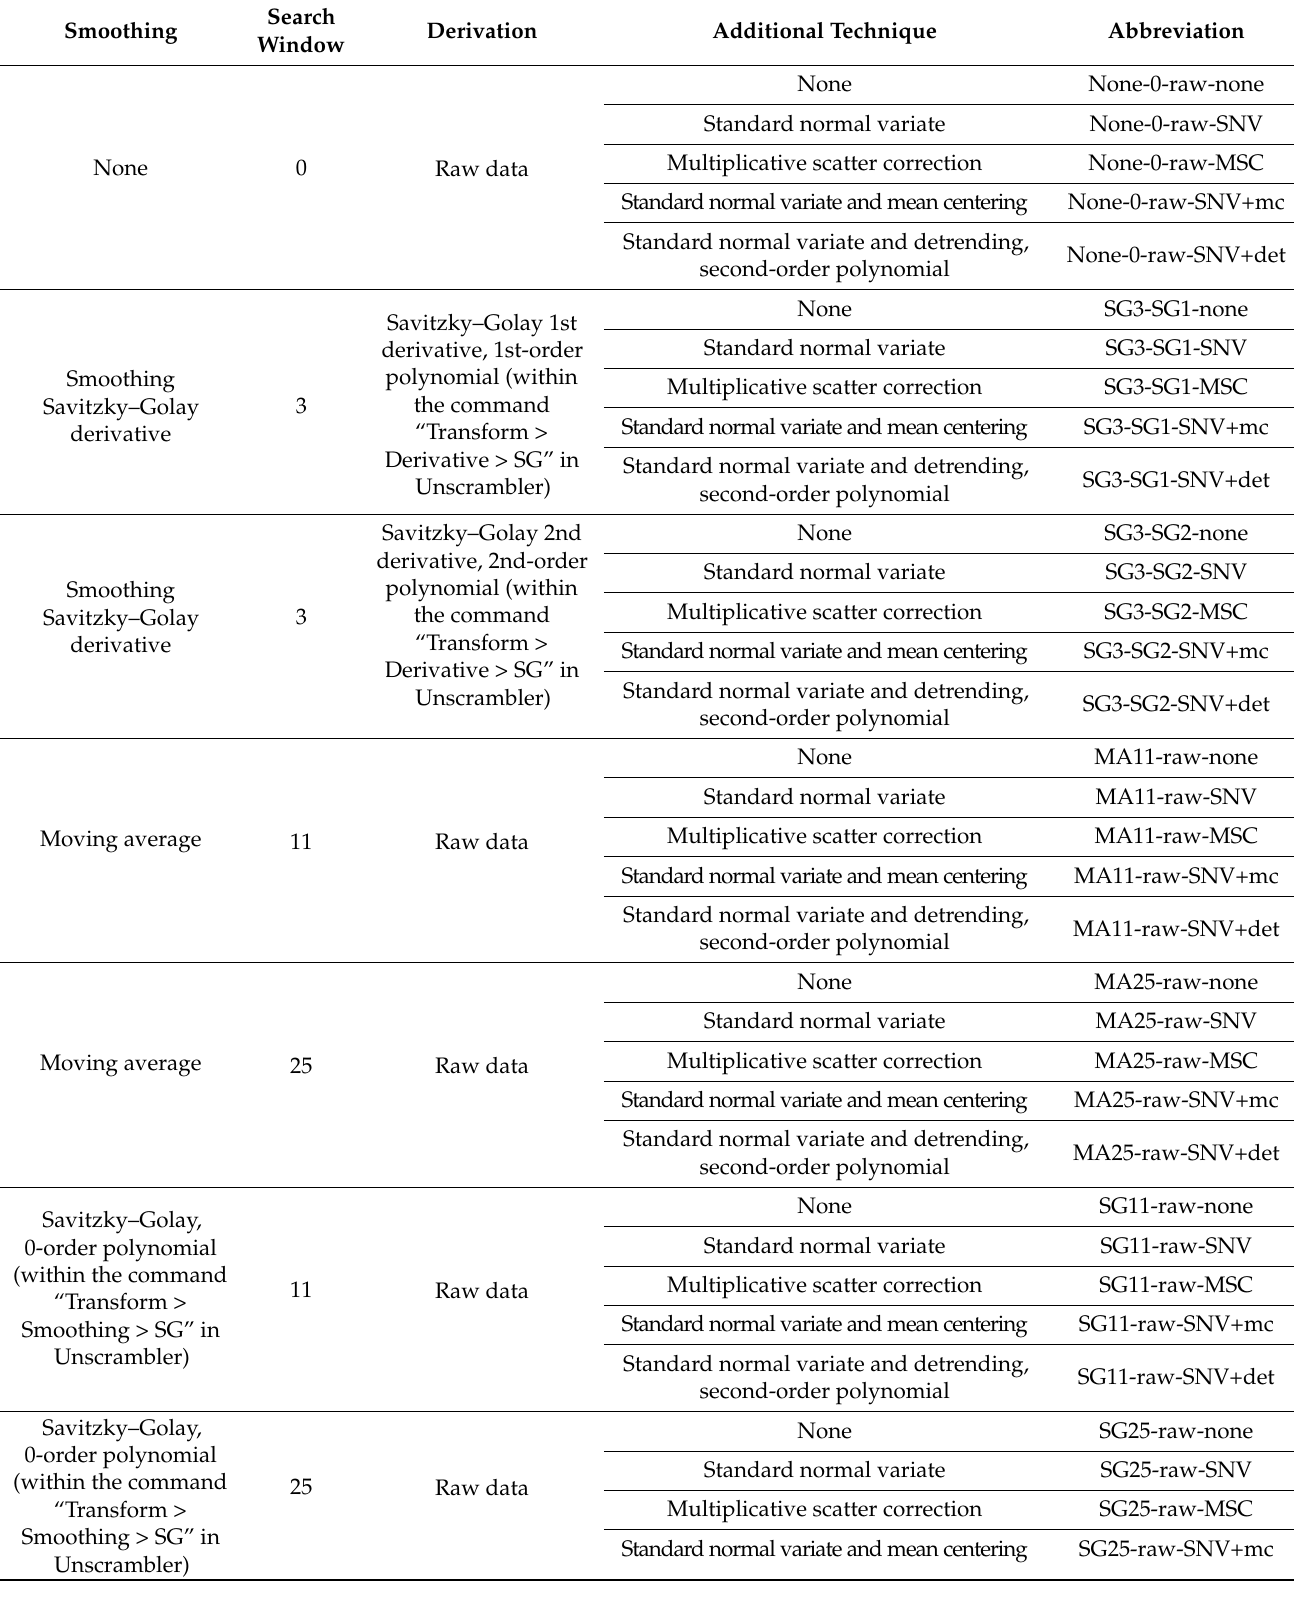
Table 3. List of all applied combinations of pre-processing techniques for the spectral